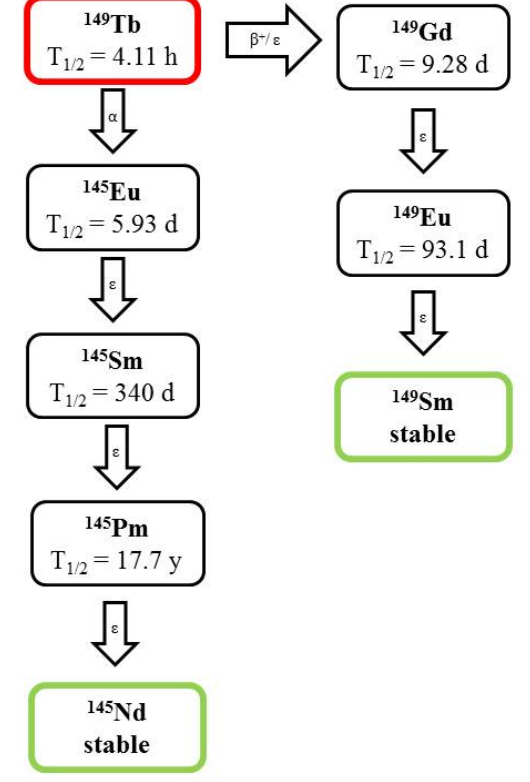
Figure 5. Decay scheme of 226 Th.